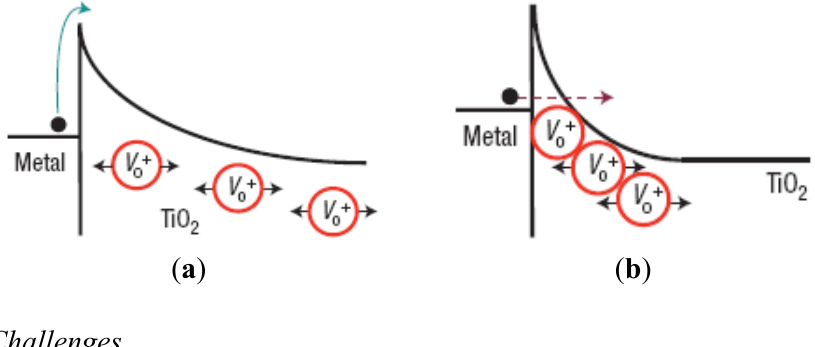
Figure 9. Energy barriers usually referred to a switch made by sandwiching a layer of titanium dioxide between two metal electrodes [98]. The energy barrier at the metal/oxide interface can be changed by using an electric field to move the positively charged oxygen vacancies (red) in the oxide layer away from the interface ( a ) or closer to it ( b ). For ( b ), the depletion width (tunneling width) is reduced to enhance electron current flow